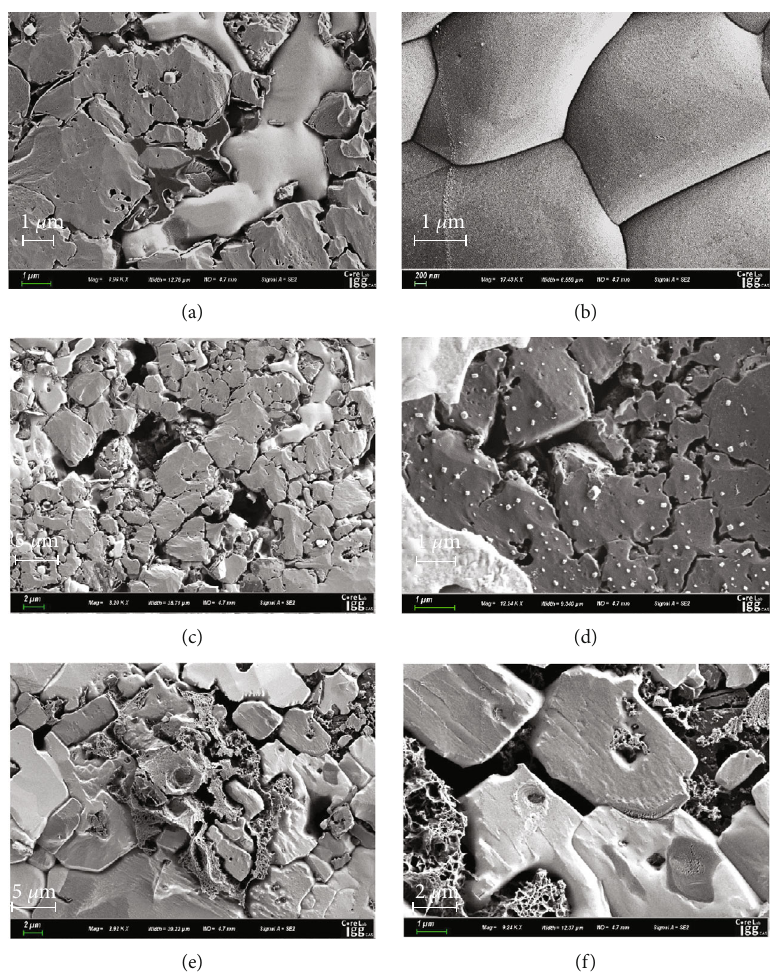
Figure 9: Pore microstructure changes after static evaporation salting out. (a) Clumps of superimposed growth morphology of salt crystals; (b) densely packed salt crystals with no internal permeability; (c) pores partially fi lled with salt crystals; (d) single-salt-particle dispersion morphology; (e, f) surface-attached layered or fl occulent growth morphology of salt